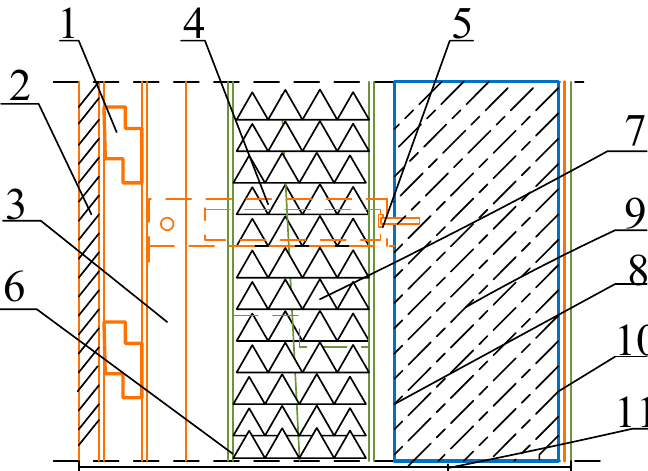
Figure 5. Heat transfer coefficients as a function of material thickness.